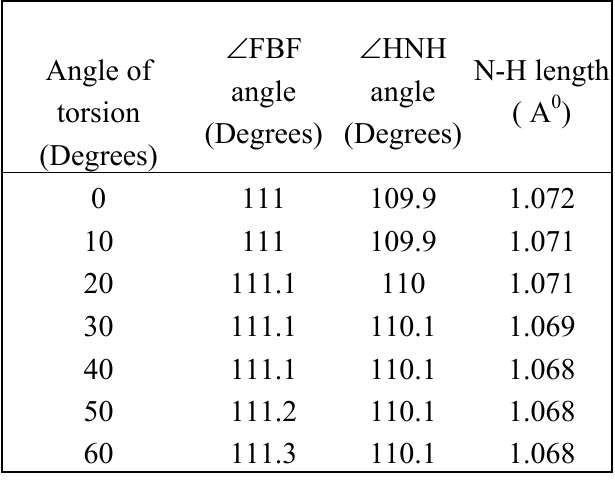
Table 1. Geometric parameters of F